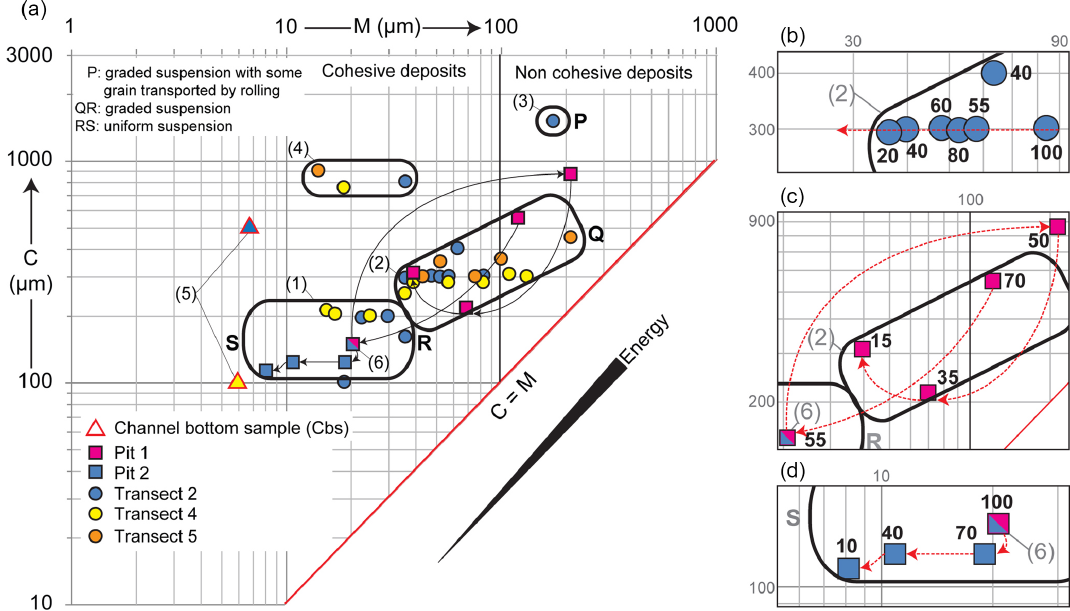
Figure 6. (a) Floodplain CM diagram and patterns according to Passega (1964, 1977). Numbers between brackets help in the presentation of the results and the discussion; (b) isolated samples with the indication of the sample depths for transect 2, pit 1 (c) and pit 2 (d) . Red arrows show the deposition